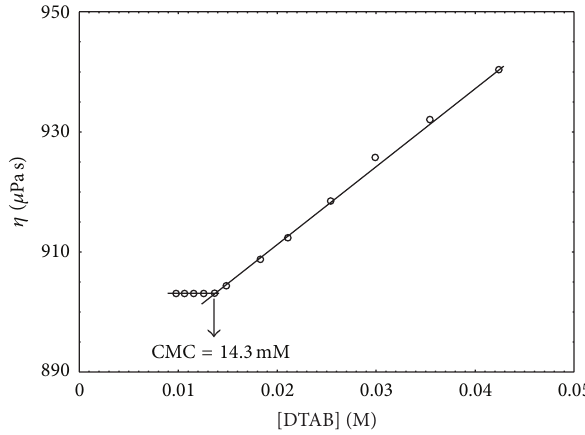
Figure 1: Viscosity versus surfactant concentration plot for DTAB in water at 298.15 K.